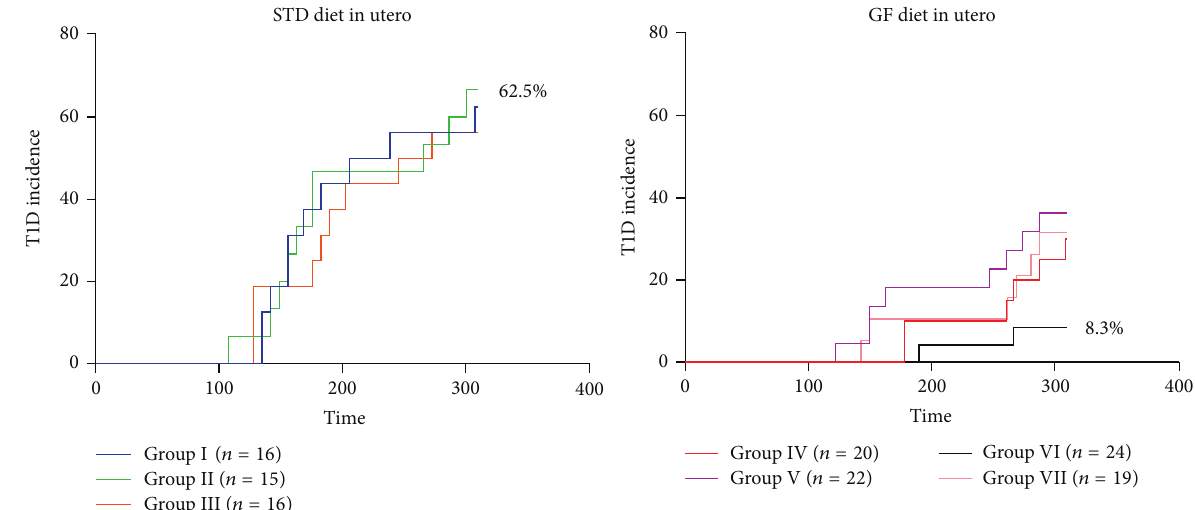
Figure 2: Kaplan-Meier data showing the incidence of diabetes in the experimental groups. Observation time was 310 days. The difference between groups I and VI is significant ( 𝑝 < 0.0001 ).